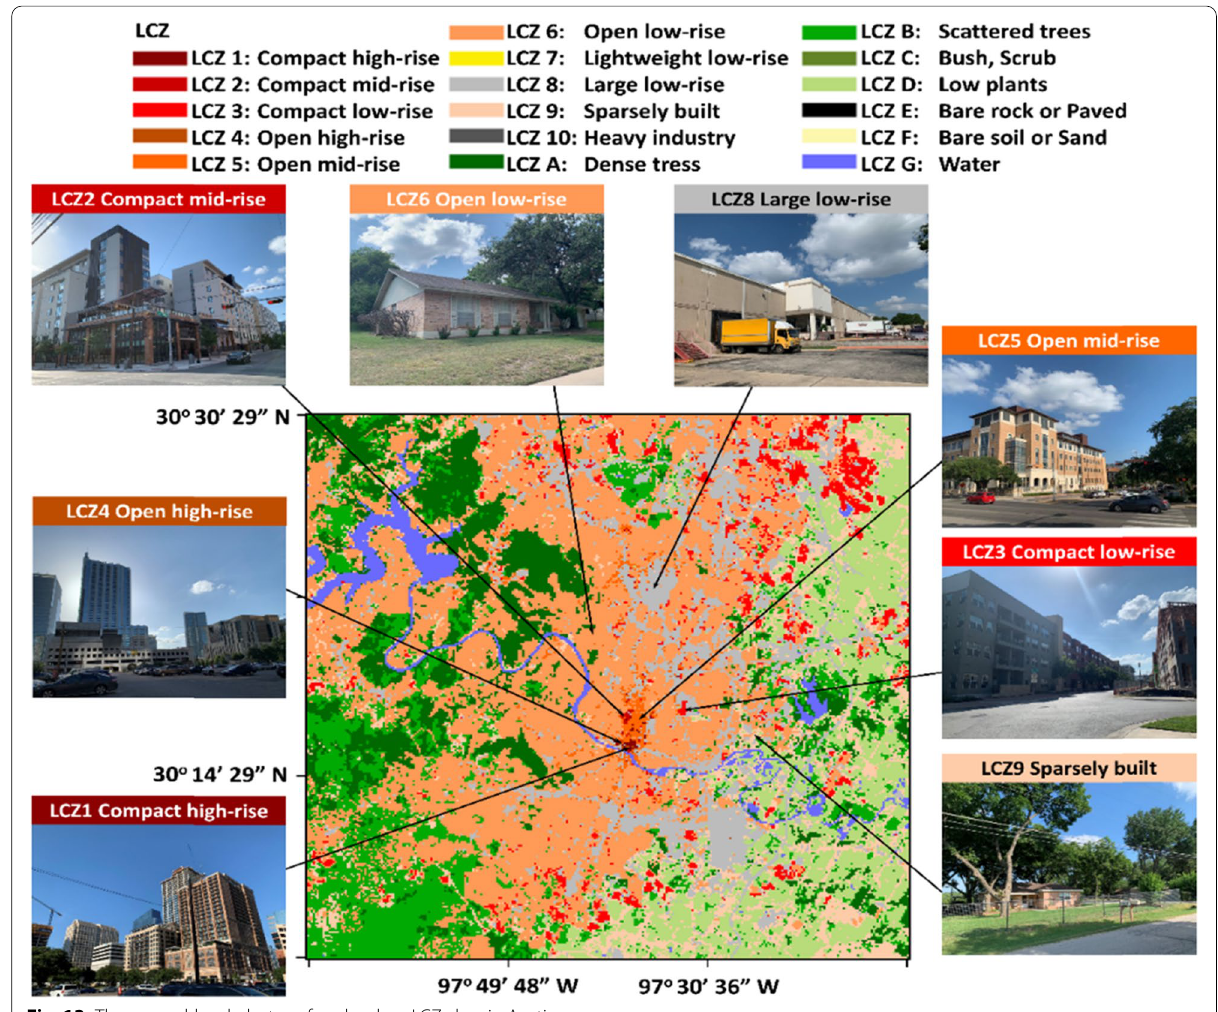
Fig. 13 The ground‑level photos of each urban LCZ class in Austin